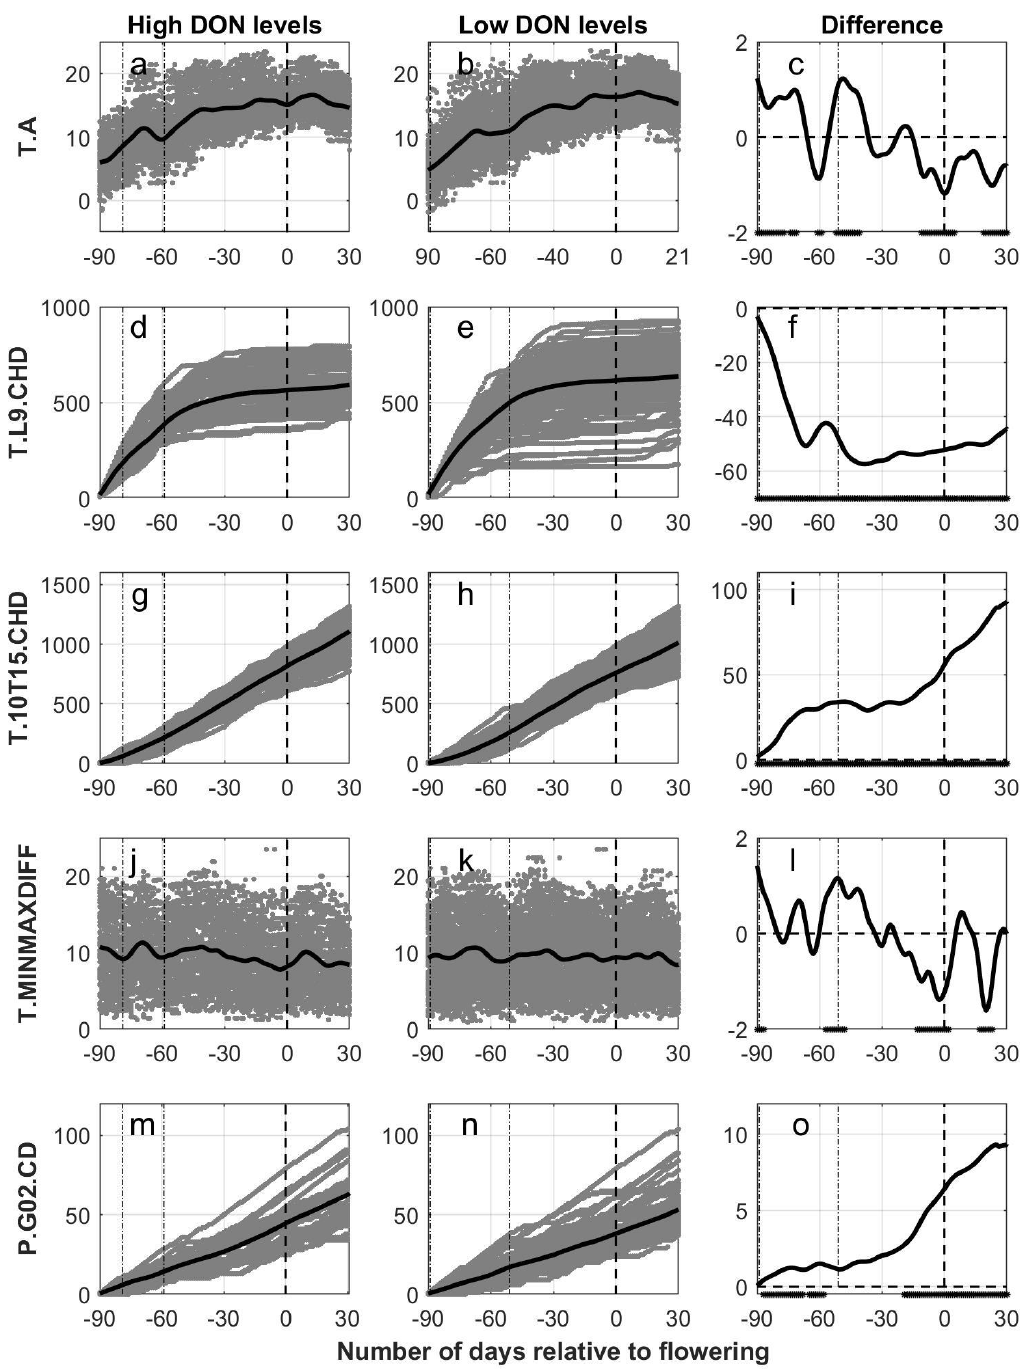
Figure 2. Calculated output data (gray) for five weather variables versus the number of days relative to estimated flowering in oats, grouped according to levels of deoxynivalenol (High DON levels, first column of panels (subfigures ( a , d , g , j , m )): DON ≥ 500 µg pr kg harvested oat. Low DON levels, second column of panels (subfigures ( b , e , h , k , n )): DON < 500 µg per kg harvested oat). Black lines indicate the functional mean values of the smooth functions derived from individual sets of weather data. In the third column of panels (subfigures ( c , f , i , l , o )), the difference between the functional mean curves (high–low) are given as black lines with a dot at the bottom of each panel indicating significant differences between the mean values (5% level). Weather data is presented from 90 days prior to 30 days posterior to flowering (dashed line at 0) estimated with the use of the phenological model